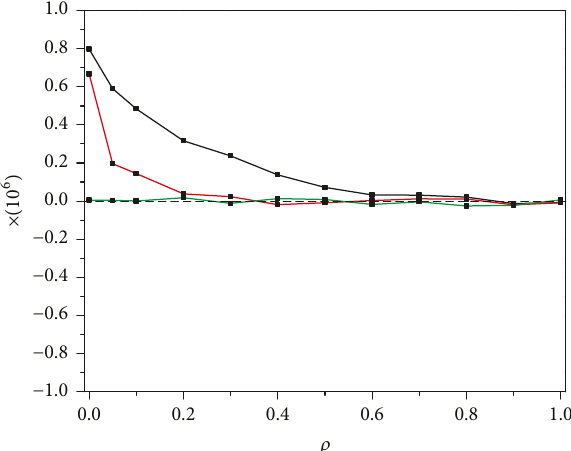
Figure 6: Dependence of mean field (at time 10 6 ) on the ratio 𝜌 of independent units (which are fixed on the lattice) for the bottom- up SOTC model (black line), top-down SOTC model (red line), and ordinary DMM with tuned control parameter 𝐾 𝑐 = 1.5 (green line). Ensemble average is done over 10